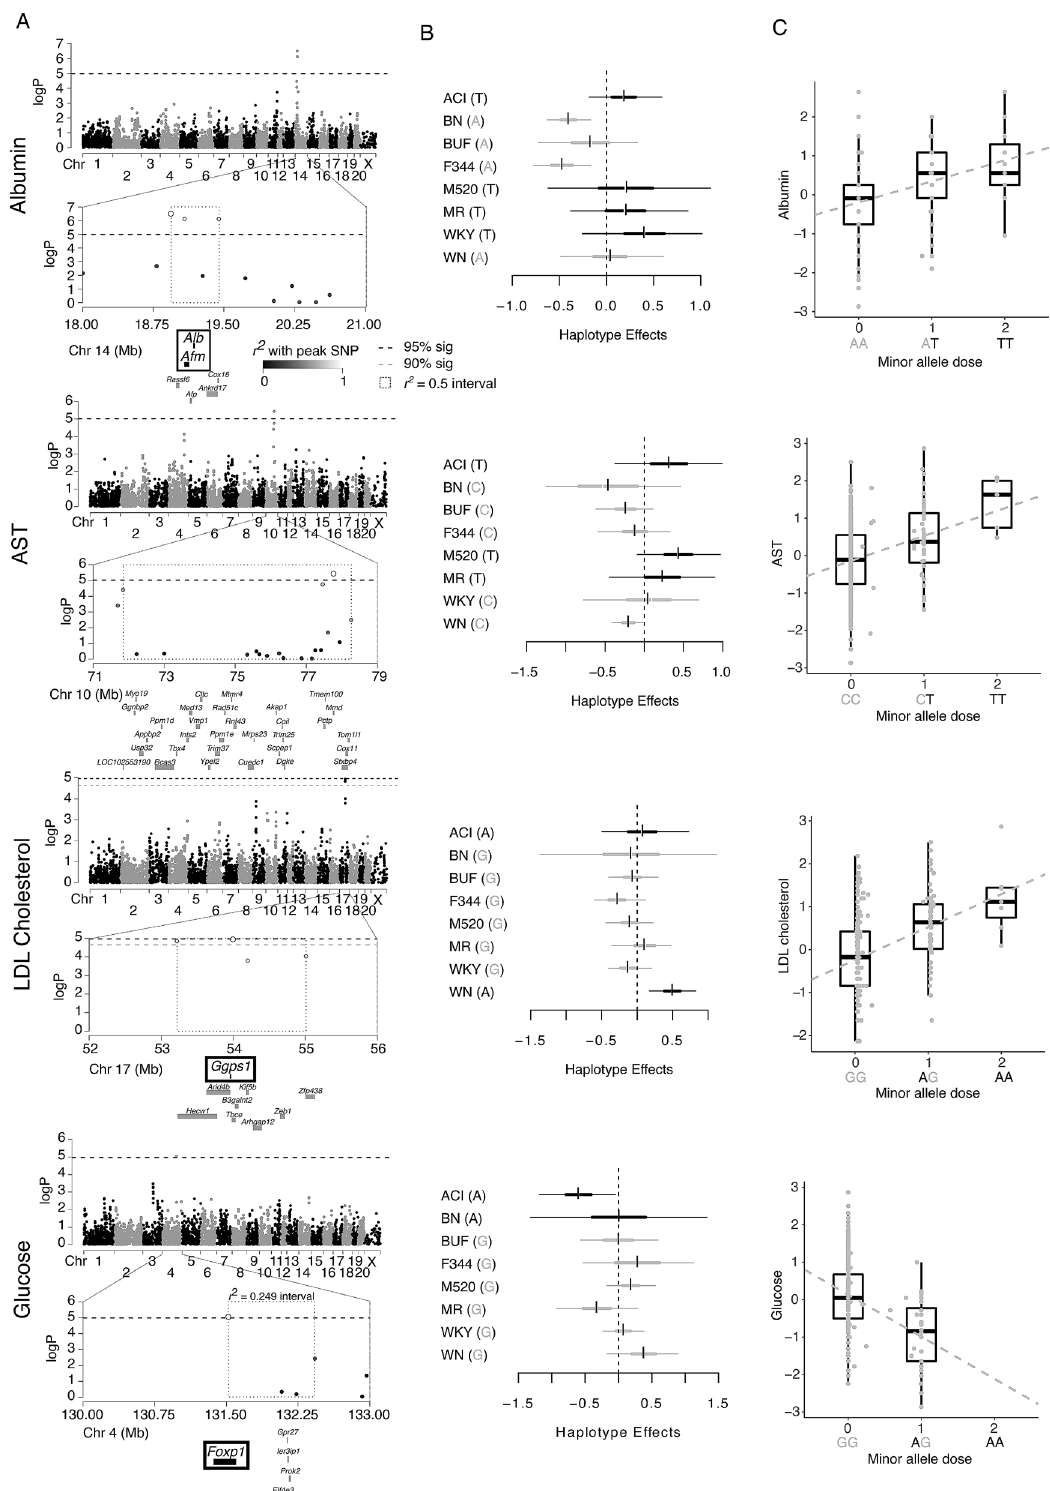
Figure 7. Genome scans for select intermediary serum biochemistry measures. ( A ) Genome scan for select serum biochemistry measures including albumin, AST, LDL cholesterol, and glucose. The x-axis is the position on the chromosome, and the y-axis is the − log 10 P level of association. Genome-wide significance thresholds were calculated using parametric bootstraps from the null model. The linkage disequilibrium support interval for each QTL is highlighted, showing neighboring markers that were correlated with the peak marker. Annotation of genes that fall within the r 2 support interval is found underneath the plot. Both Abm and Afm fall within the albumin QTL and are likely candidate genes. Foxp1 is directly below the peak association with no other markers in high LD (r 2 = 0.5) and is the most likely candidate for the glucose QTL. QTL effects as ( B ) additive haplotype effects estimated with the Diploffect model, which takes into account uncertainty in haplotype state, and ( C ) in the actual data, plotted as phenotype vs minor allele dosage of the peak marker. Boxplots represent most likely